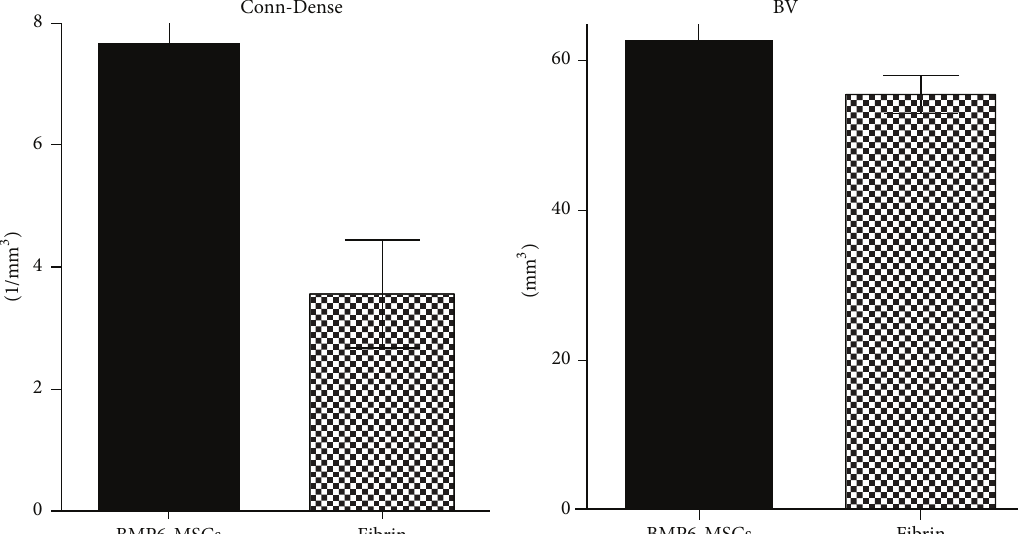
Figure 4: Quantification of bone regeneration in lumbar vertebral defects. Bone volume (BV) and connectivity density (Conn-Dense) parameters were higher in lumbar defects treated with BMP6-MSCs compared to defects treated with fibrin gel only. Statistical significance difference was not reached, probably due to the small sample size (bars indicate SE, 𝑛 = 3